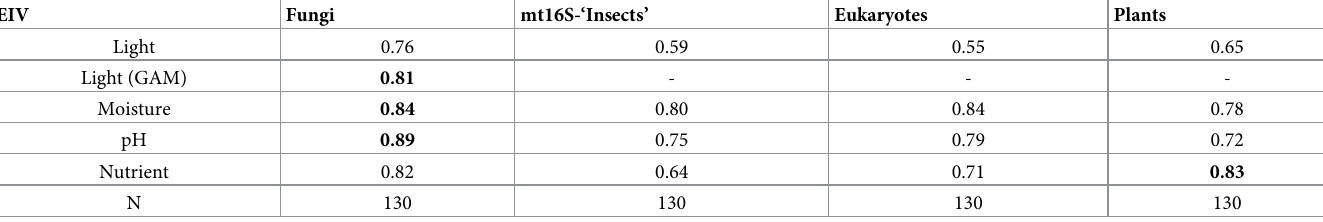
Model R 2 values of linear models with EIVs of light, soil moisture, pH and nutrient status as response variable and NMS ordination axes of soil OTU